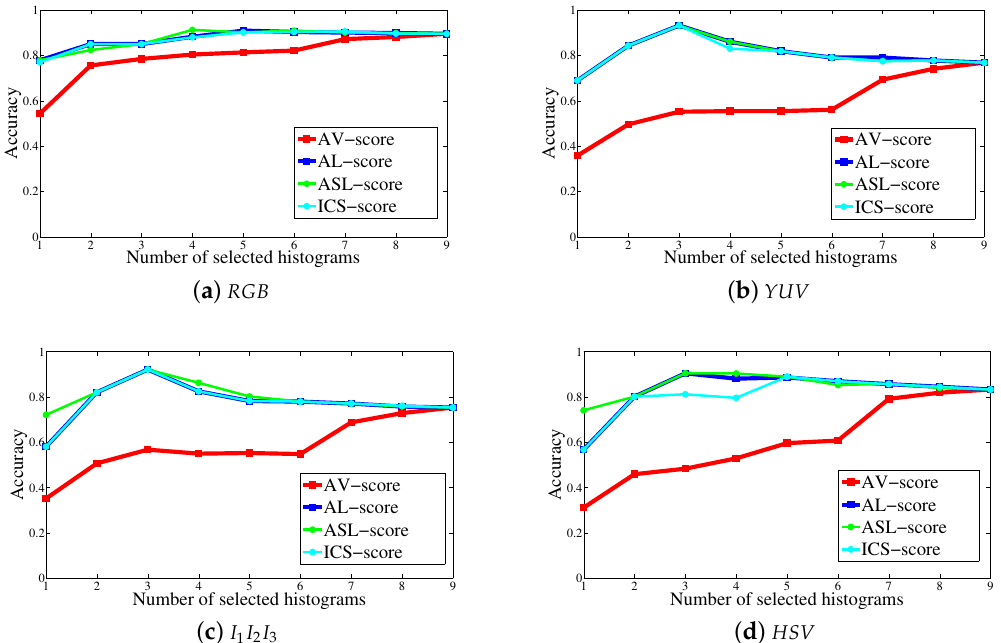
Figure 2. Classification accuracy R d according to the number d of ranked histograms on USPTex.